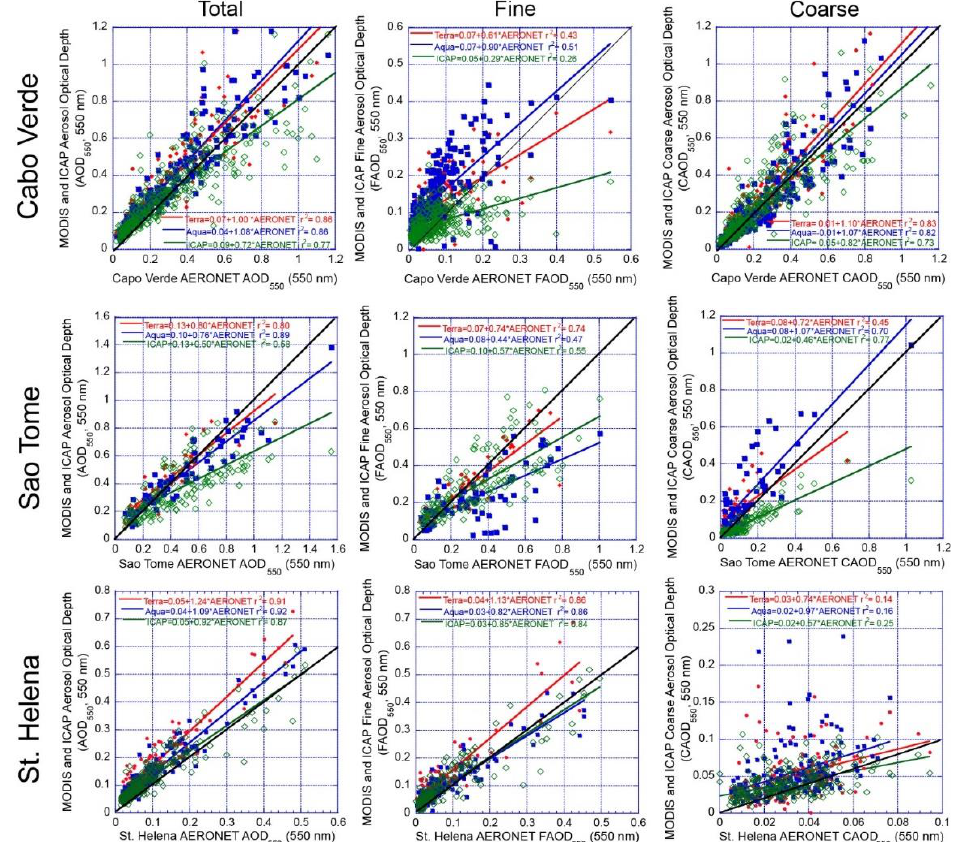
Figure 14. Scatter plots of total AOD (AOD 550 ), fine mode AOD (FAOD 550 ), and coarse mode AOD (CAOD 550 ) for daily averages from three AERONET sites located on islands in the Atlantic off Africa. Top row Cabo Verde sampling the Saharan dust plume (16.7°N, 22.9°W); middle row, Sao Tome representing the Sahel and Gulf of Guinea with a mixture of mixed dust, biomass burning and pollution (0.4°N, 6.7°E); and lower row, St. Helena, dominated by central Africa biomass burning (~15.9°S, 5.7°W).